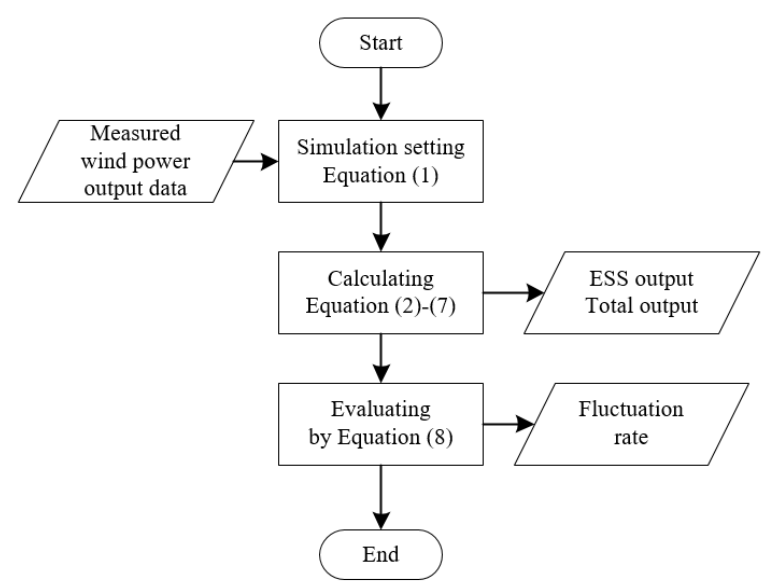
Figure 20. Flow chart for the implementation of simulation.